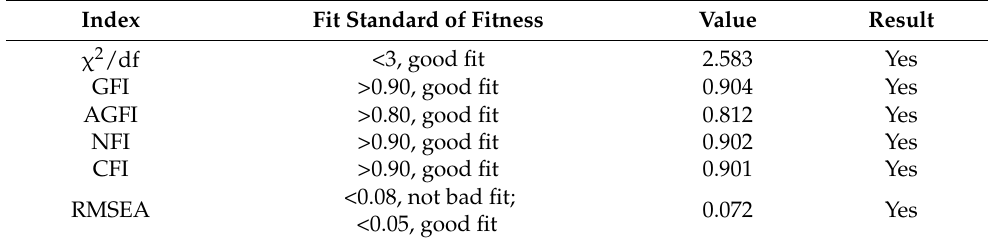
Table 5. Test results of model